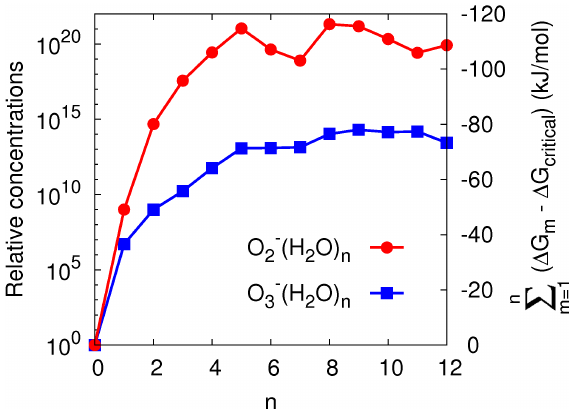
Fig. 2. Development of concentrations and accumulated energies of the O − x ( H 2 O) n clusters at 298K and 50 % relative humidity. Both curves correspond to both vertical axis via Eq. (2).